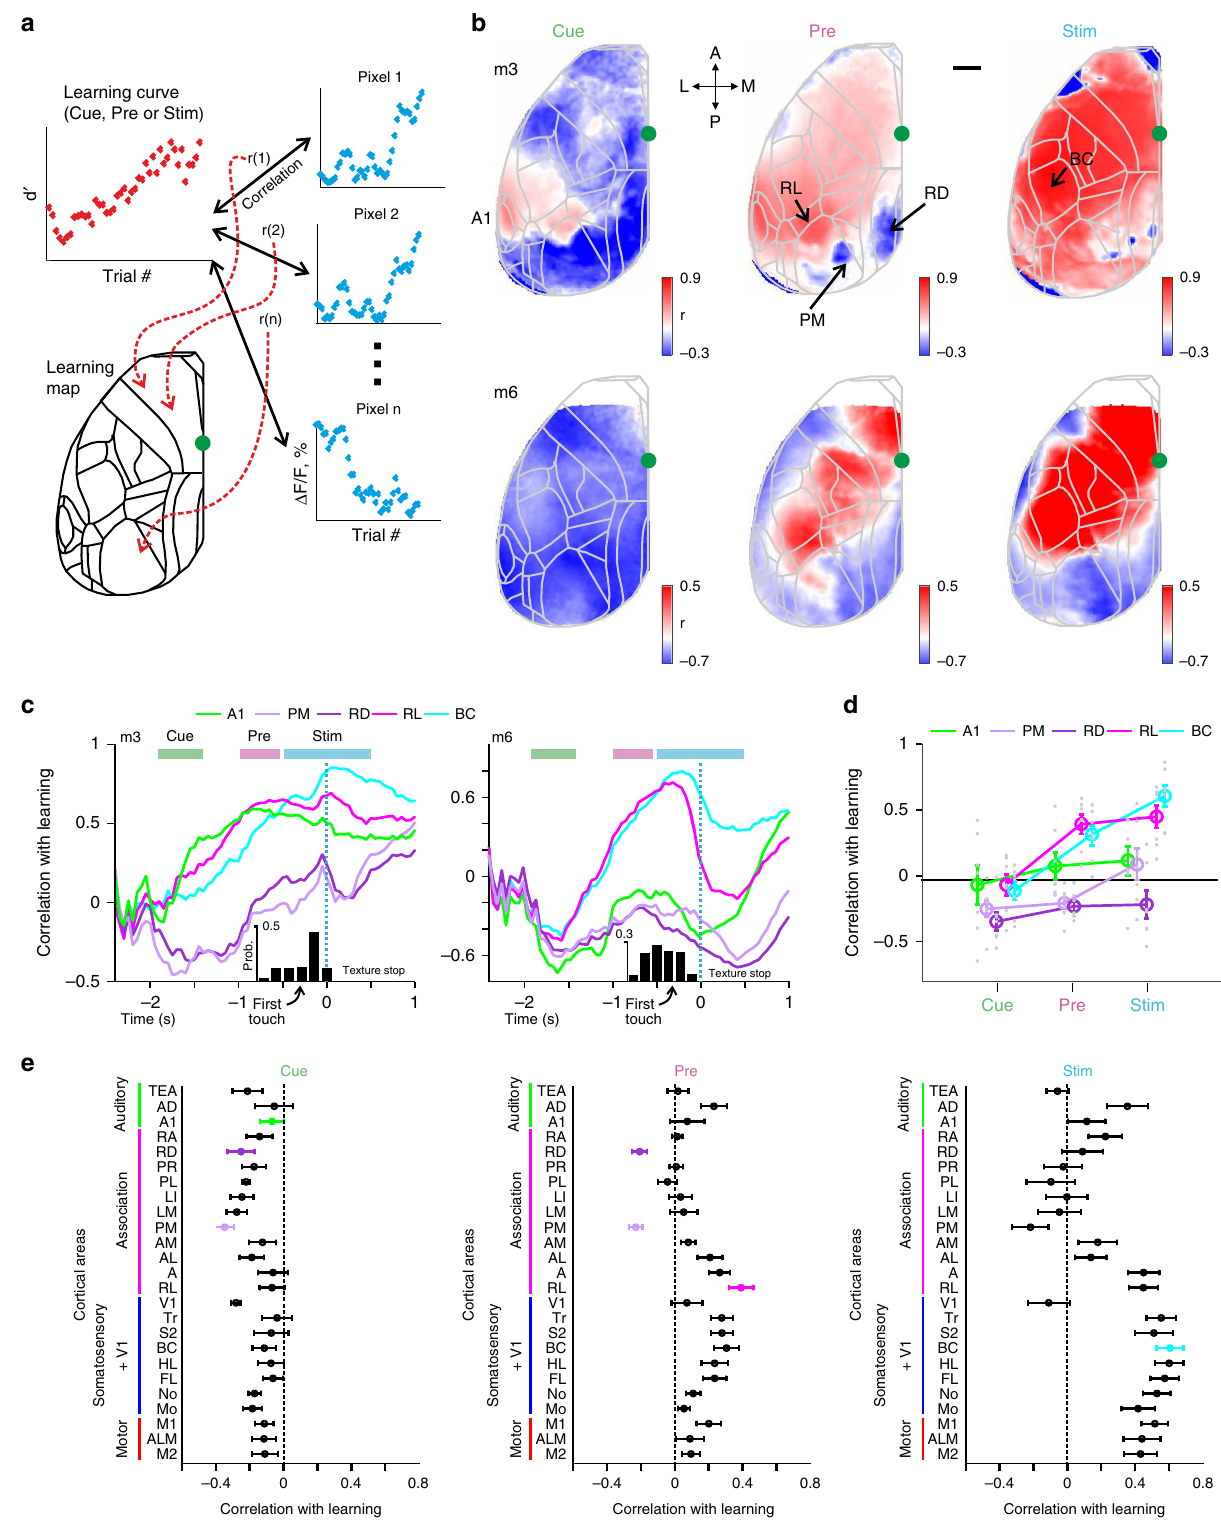
Fig. 5 Learning maps reveal dissociation of association areas in relationship to learning. a Schematic illustration for calculating a learning map. Each pixel in the maps re fl ects the correlation coef fi cient ( r ) between the mouse ’ s learning curve and the curve of learning-related Δ F / F change of the respective pixel. The latter can be averaged across the key trial periods (i.e. cue, pre, or stim) or calculated for each time frame. b Learning maps during cue-, pre-, and stim-periods in two example mice. Color denotes r -values. Scale bar is 1 mm. c Correlation with learning as a function of time for the 5 key areas in two example mice. Histograms at the bottom indicate distribution of the fi rst touch. d Correlation with learning during cue-, pre-, and stim-periods for the 5 areas. Error bars are s.e.m. across mice. Gray dots depict individual mice. e Correlation with learning during cue-, pre-, and stim-periods for all areas. Error bars are s.e.m. across